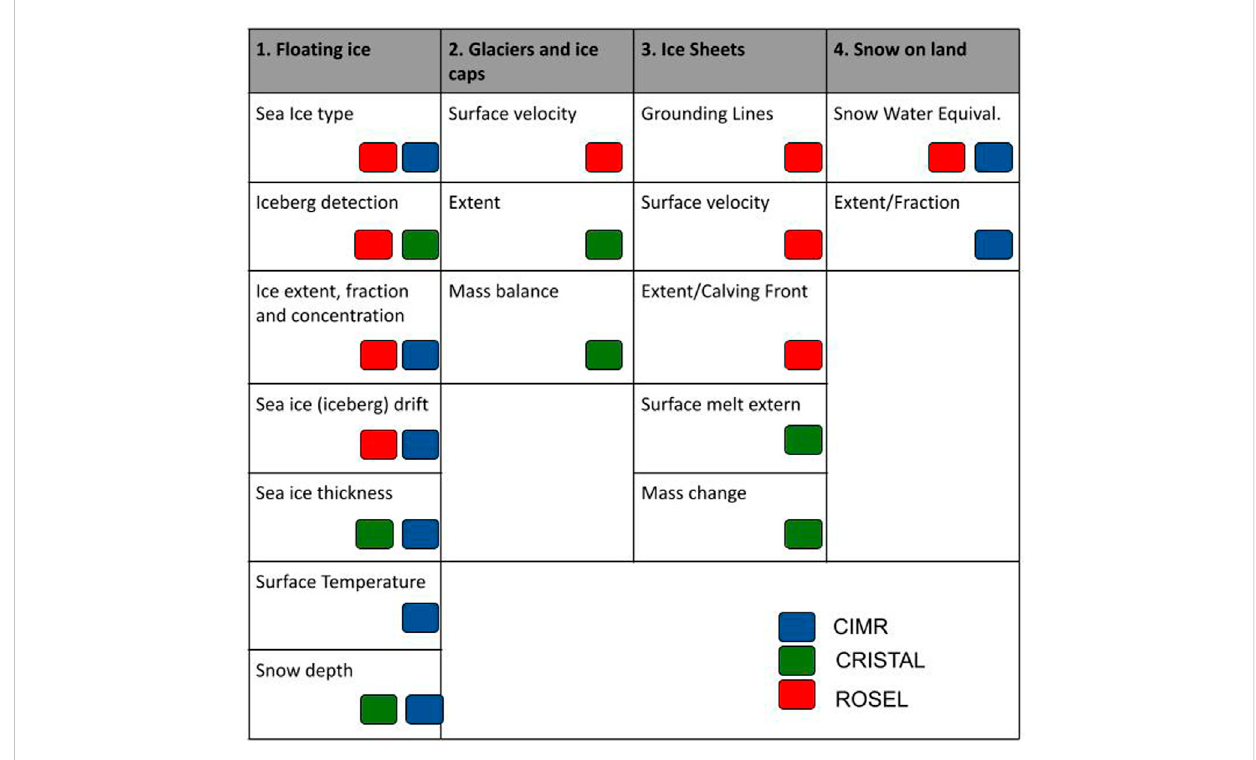
FIGURE 1 Highpriorityenvironmentalparametersidenti fi edbythePolarExpertGroup(PEGIII)andwithcolorcodes,theparameterswhichcanbeacquiredby each of the polar Copernicus Sentinel Expansion Missions. Blue dots indicate data from CIMR, green dots from CRISTAL, and RED dots from ROSE-L.